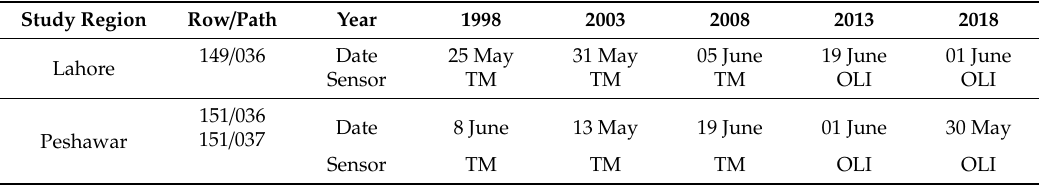
Table 1. Satellite images used in this